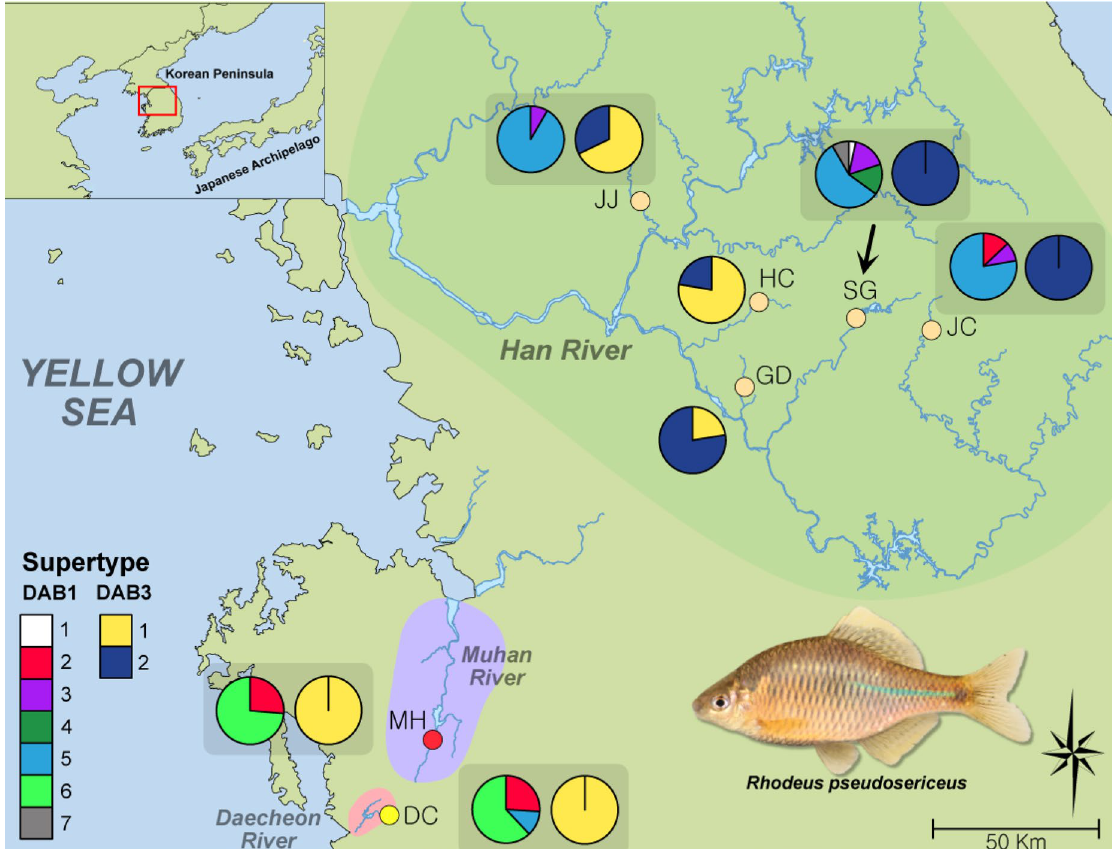
Figure 1. The collection site information (population) of Rhodeus pseudosericeus with a map in the square left above showing the locations of the Korean Peninsula and the surrounding areas. The locations of the seven R. pseudosericeus populations collected from the Daecheon River (DC), Muhan River (MH) and Han River (GD, HC, JC, JJ and SG) were indicated with the pie graphs showing the frequencies of DAB1 and DAB3 supertypes. on the GPS coordinates of the populations are as follows: DC (36°23 ′ 28.00 ″ N, 126°39 ′ 48.00 ″ E), MH (36°27 ′ 38.63 ″ N, 126°44 ′ 15.91 ″ E), GD (37°20 ′ 2.00 ″ N, 127°40 ′ 37.00 ″ E), HC (37°30 ′ 40.71 ″ N, 127°38 ′ 47.83 ″ E), JC (37°25 ′ 52.32 ″ N, 128°10 ′ 47.16 ″ E), JJ (37°44 ′ 50.65 ″ N, 127°26 ′ 4.05 ″ E) and SG (37°32 ′ 29.17 ″ N, 127°58 ′ 9.43 ″ E). The shape of the map was downloaded from http:// www. biz- gis. com. The map was processed using QGIS 3.4 (Open Source for Geospatial Foundation Project; http:// qgis. osgeo. org) and converted into a vector image that